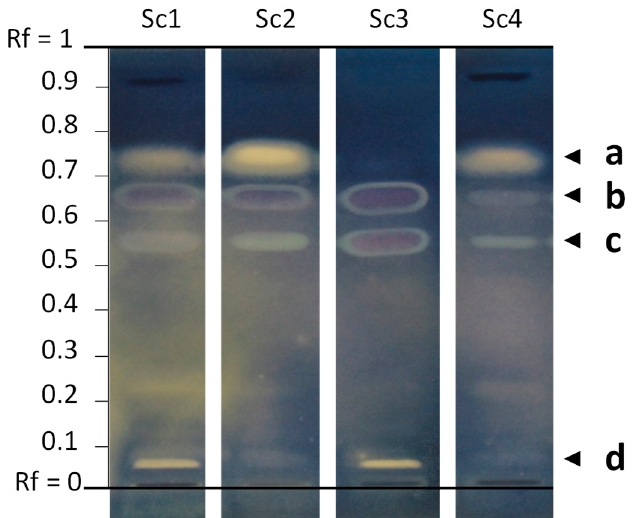
Figure 4. TLC bioautograms obtained with the EtOAc extracts from the four Scleroderma citrinum samples against the MDR strain SA2. Compounds a – d are discussed more in details in the text regarding their occurrence and selectivity.